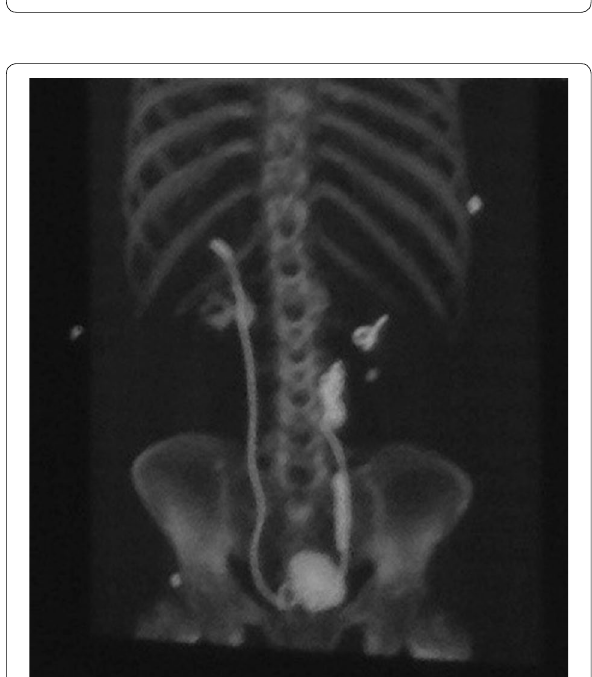
Fig. 3 Fracture present in the